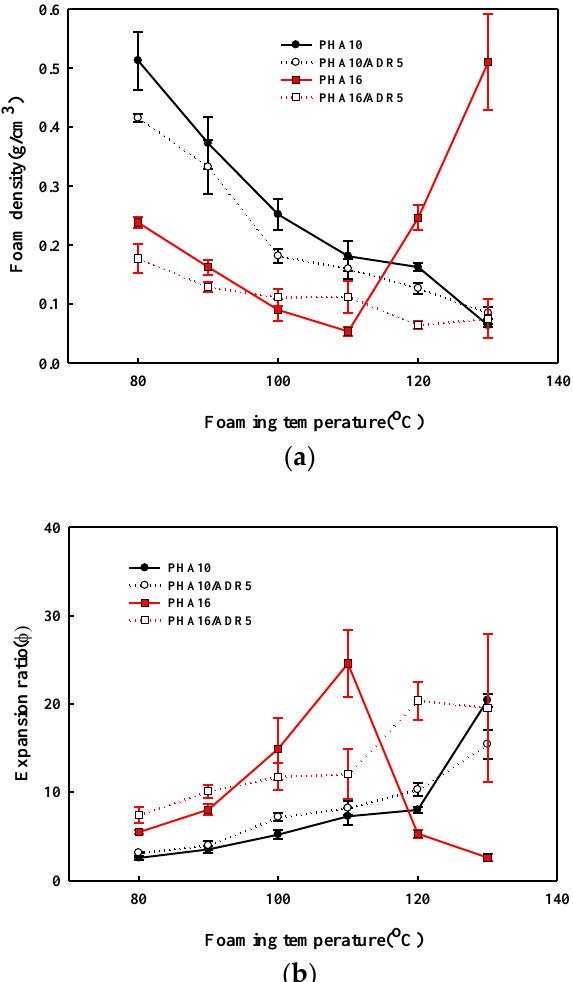
Figure 10. Effect of chain extender on the structure of the P(3HB- co -4HB) foams; ( a ) foam density; ( b ) expansion ratio.